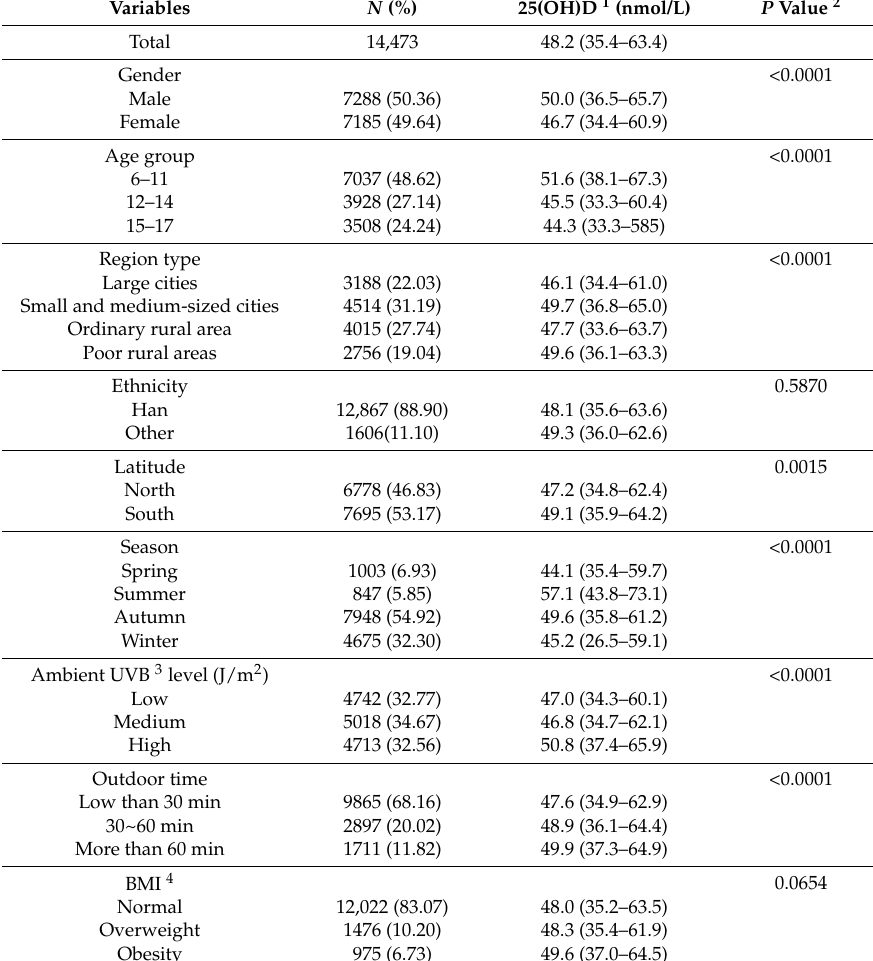
Table 1. 25(OH)D concentration for children and adolescents from the China Nutrition and Health Survey